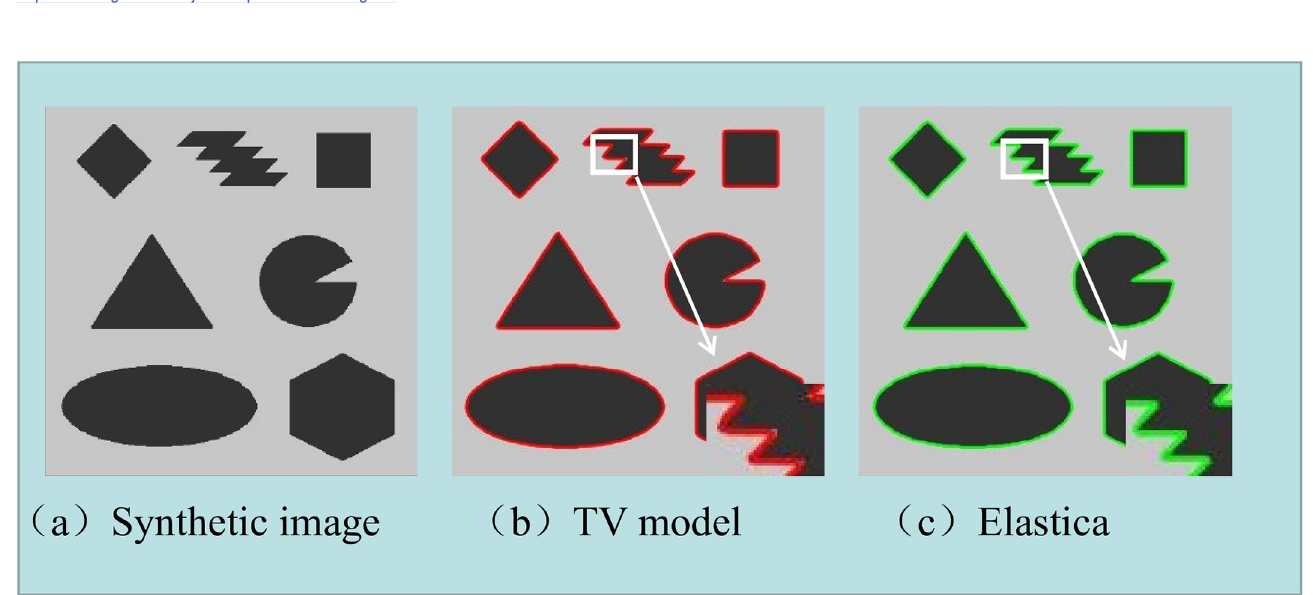
Fig 5. Image segmentation results by TV model and Euler’s elastica method.